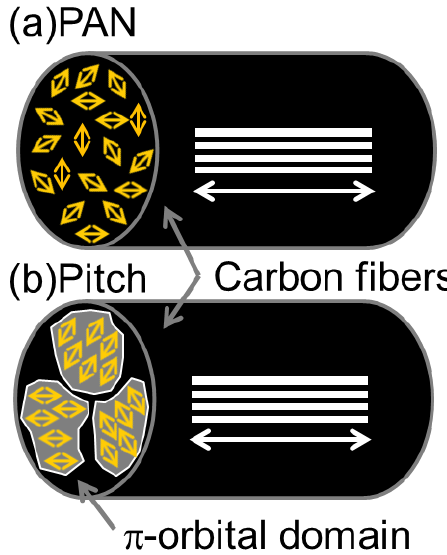
Figure 3. Schematic of the distribution of the π -orbital-oriented domains and the stacks of graphene sheets in a single ( a ) PAN- and ( b ) pitch-based CF, respectively. The white and yellow two-way arrows represent the directions of the graphene sheets along the fiber and within the fiber cross section, respectively.